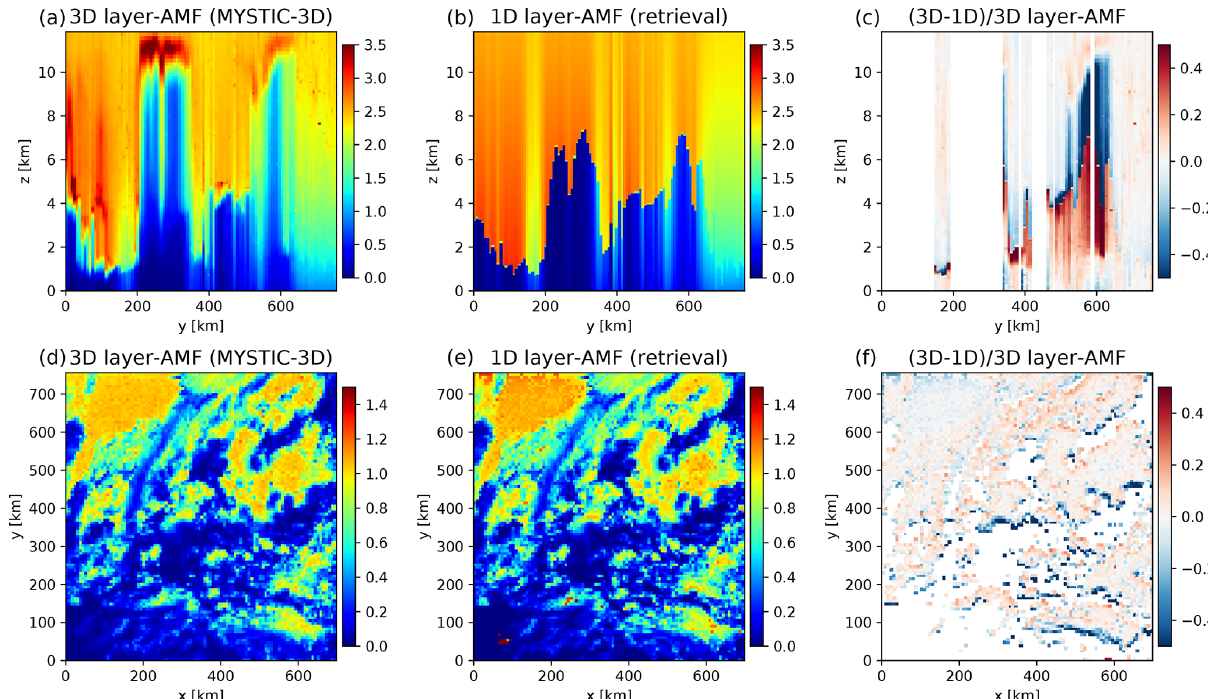
Figure 13. Panel (a) shows the vertical cross section of layer-AMFs calculated using 3D radiative transfer with the full cloud information as input (cross section at x = 256 . 8km). Panel (b) shows the corresponding layer-AMF calculated within the retrieval algorithm using 1D radiative transfer where the cloud is approximated as a Lambertian surface at the effective cloud height. Panel (c) shows the relative difference between the 3D and 1D layer-AMF. Panels (d) , (e) and (f) show the same layer-AMFs as in the panels (a) , (b) and (c) but for a horizontal cross section at 0.5km altitude.